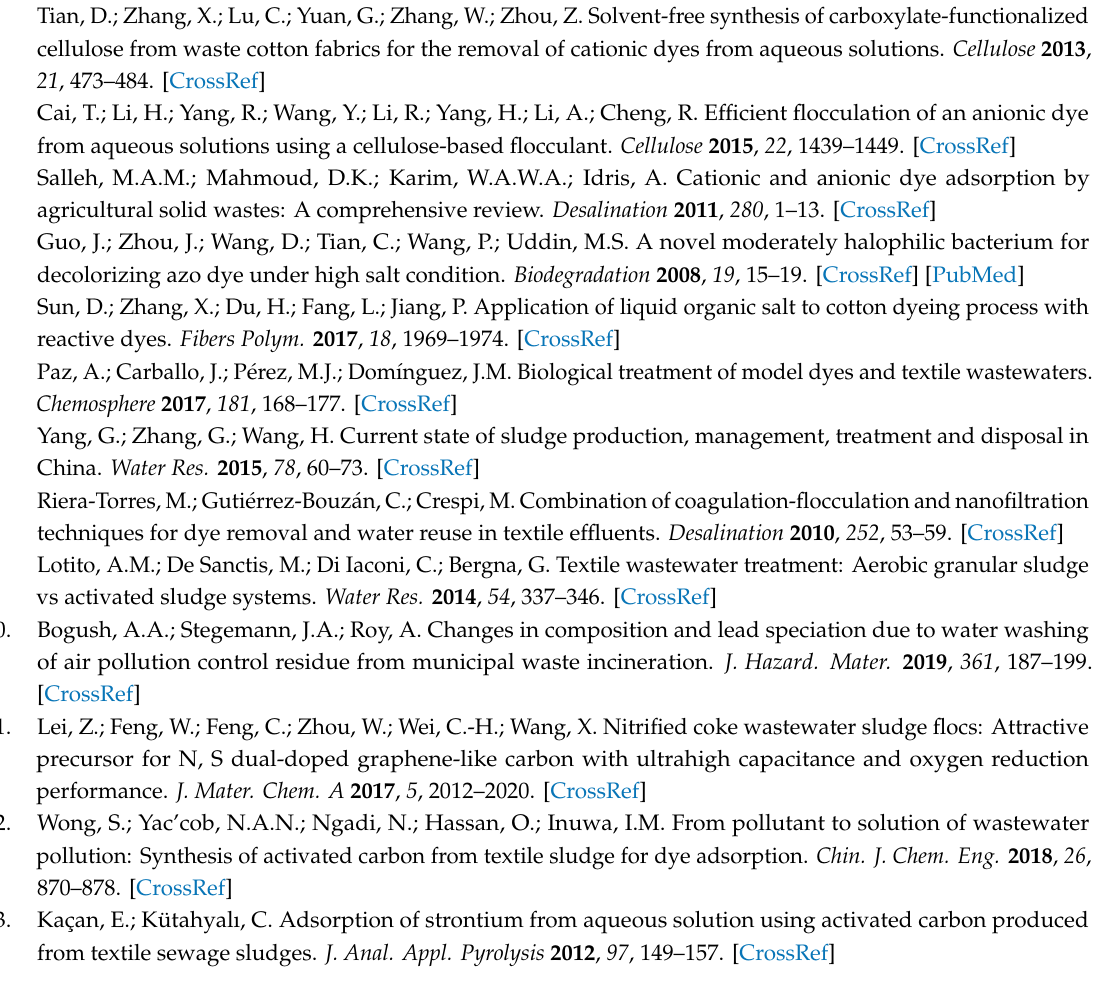
Figure S1: The structure of K-2BP. Figure S2: The structure of 2,4-bis(dimethyl amino)-6-chloro-[1,3,5]-triazine-chitosan (BDAT-CTS). Figure S3: The equation to hydrolysis of K-2BP. Table S1: The textural parameters of NSC-Fe- x materials. Figure S4: SEM images of (a) NSC-Fe-1 and (b) NSC-Fe-3. Figure S5: AFM images and the thickness of NSC-Fe-1 (a, b) and NSC-Fe-3 (c, d). Table S2: The concentrations of N species in NSC-Fe- x catalysts determined by XPS measurements. Table S3: Comparation of NSC-Fe-2 with carbon materials for oxygen reduction reaction (ORR) reported recently. Figure S6: Tafel plots of NSC-Fe-1, NSC-Fe-2, NSC-Fe-3 and commercial Pt / C catalysts. Figure S7: CV curves at different scan rates of (a) NSC-Fe-1, and (b) NSC-Fe-3. Figure S8: Nyquist plot of the EIS for NSC-Fe-1, NSC-Fe-2 and